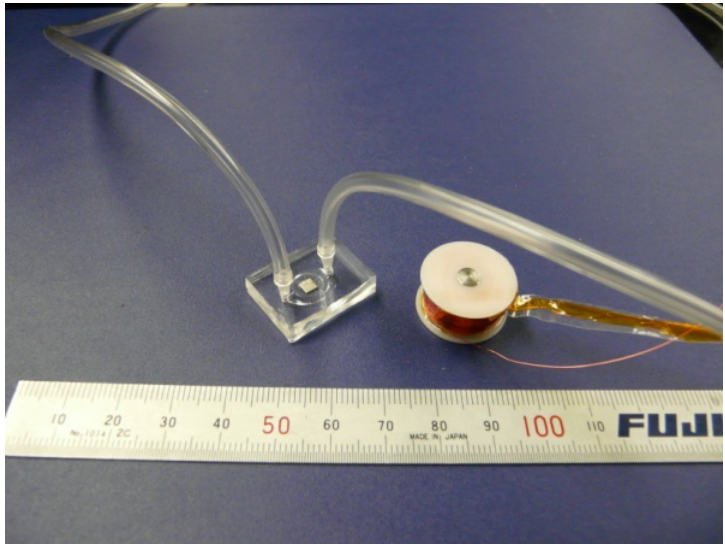
Figure 2. Micropump assembly and electromagnetic